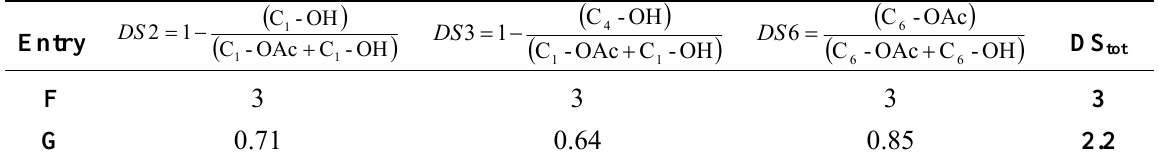
Table 1. Determination of the DS of CA F and G from the 13 C NMR measurements in DMSO-d6 in the presence of Chromium(III) acetylacetonate ( T = 323